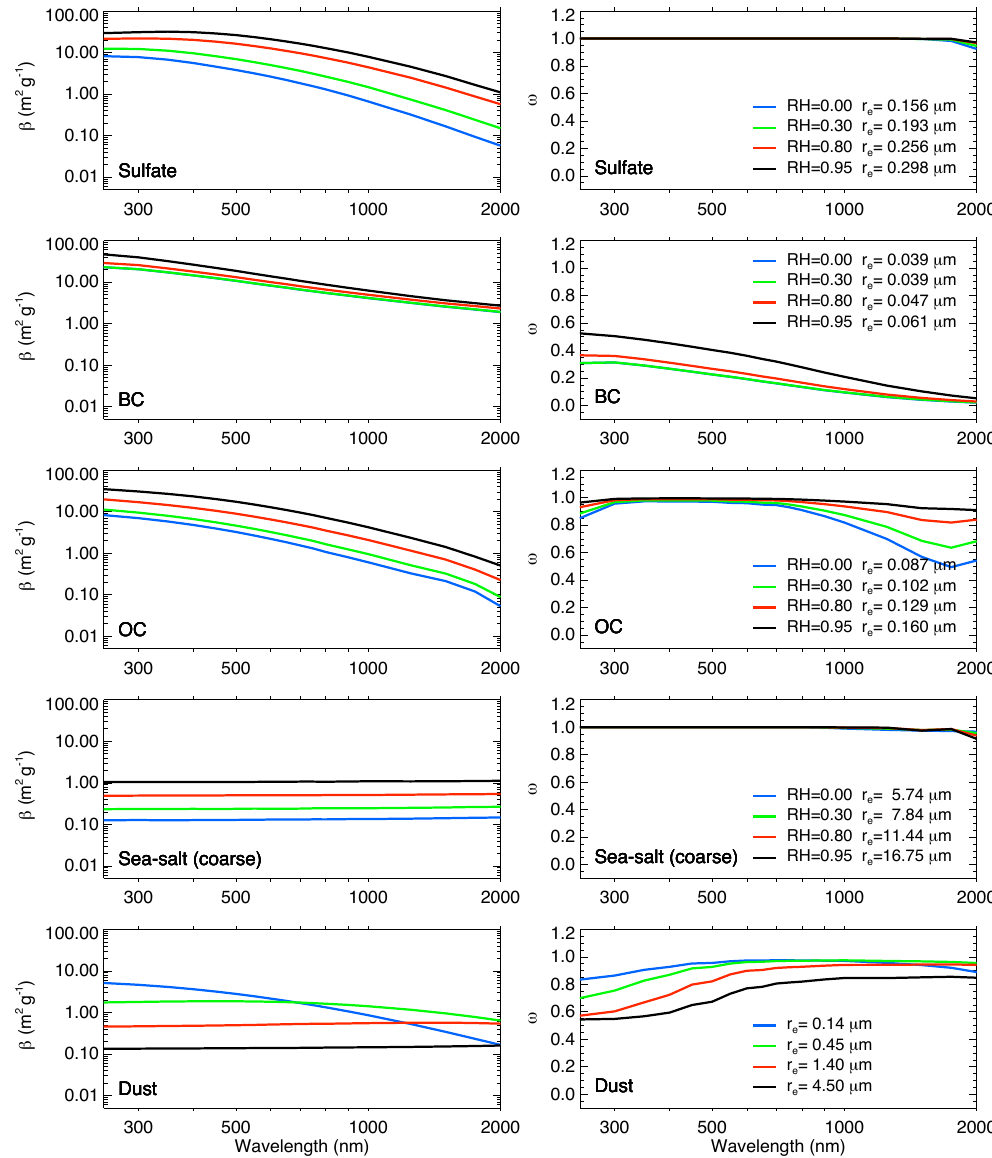
Fig. 3. Mass extinction cross-section (aka mass extinction efficiency) β (left column) and single scattering albedo ω (right column) for sulfate, BC, OC, coarse sea salt, and dust as a function of wavelength from 250 to 2000nm. Four different sizes of each species are shown with respective effective radius ( r e ) at different RH values indicated in the panels in the right